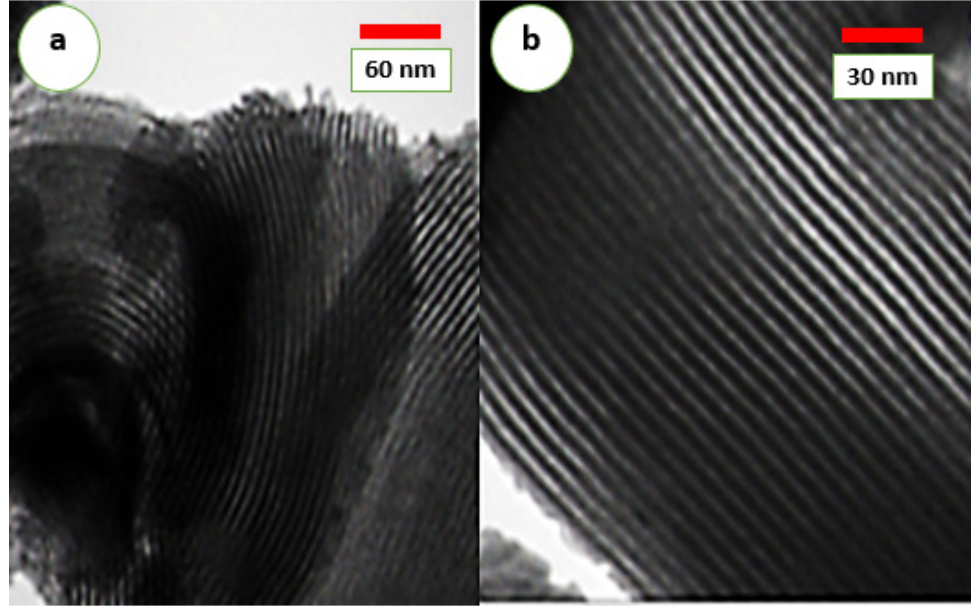
Figure 4. TEM images of ( a ) SBA-15 and ( b ) SBA-Pr-Is-TAP.